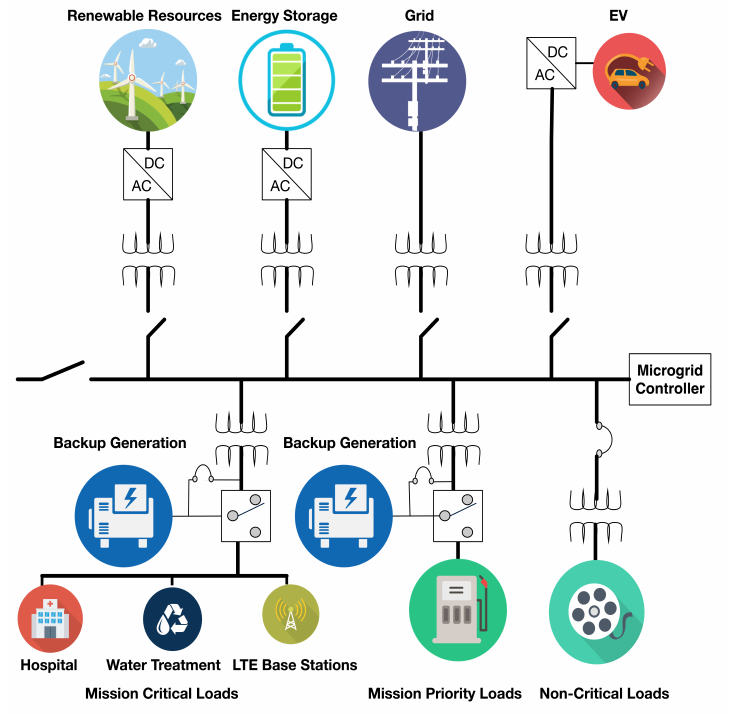
Figure 1. Sample microgrid